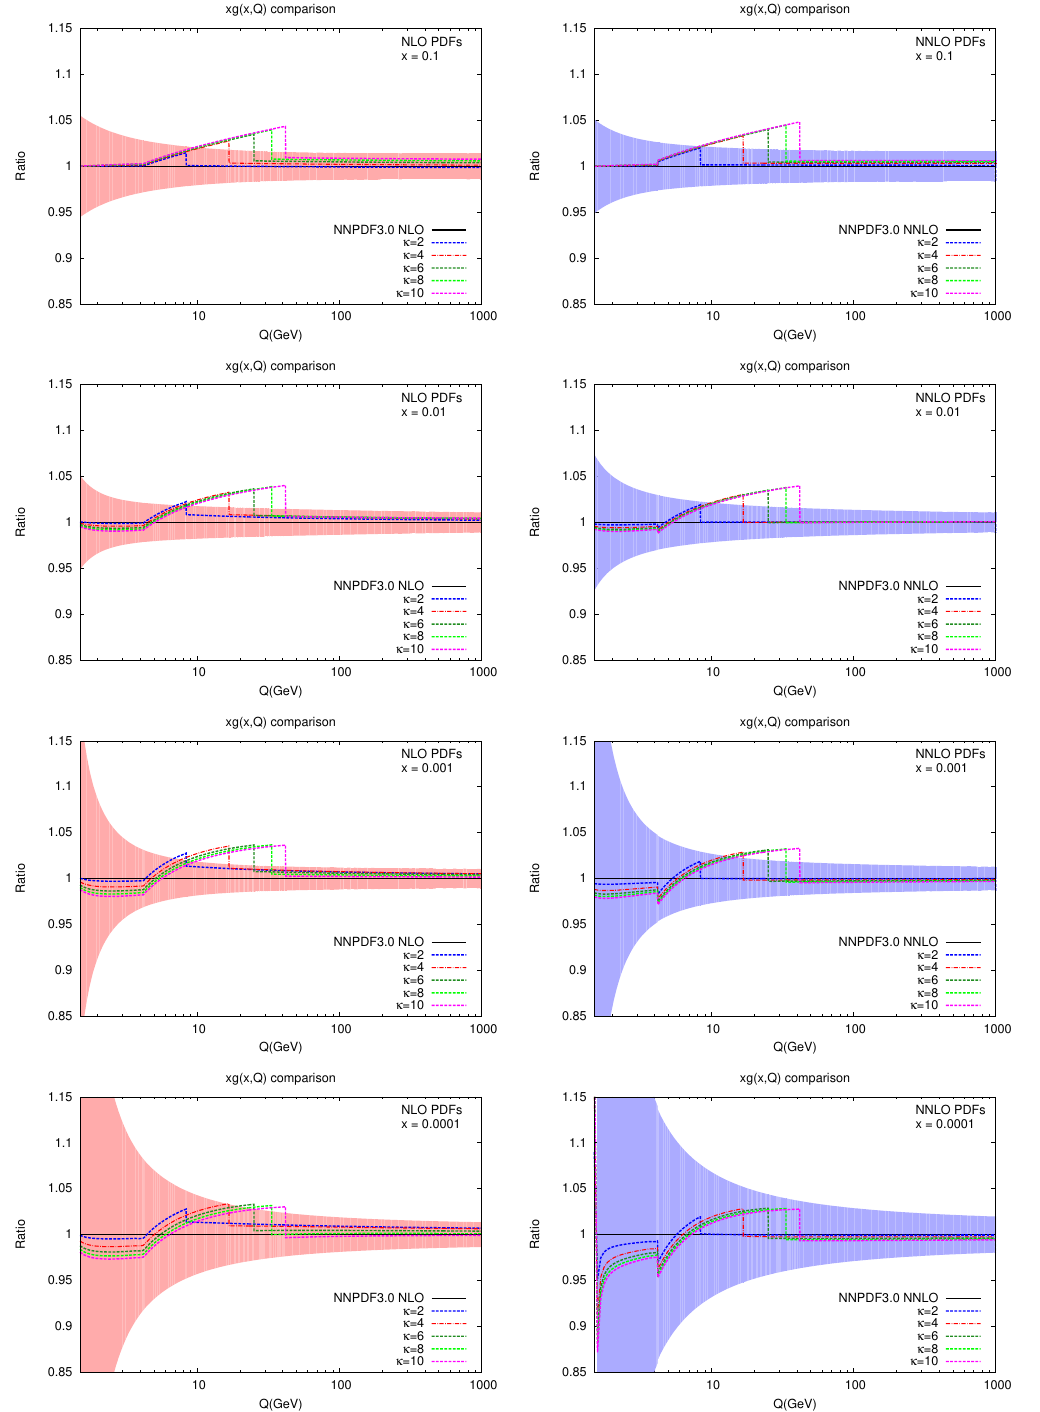
Figure 13 . Ratio between the gluon pdf for (cid:20) =2,4,6,8,10 and the standard (cid:20) =1 at NLO (left) and NNLO (right) as a function of the factorization scale Q and for four values of the partonic fraction x